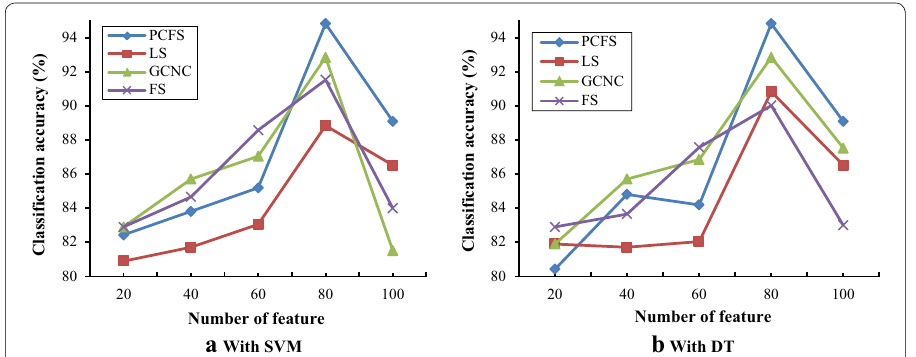
Fig. 4 Classification accuracy (average over 10 runs), on multiple features dataset with respect to the number of selected features with a SVM classifier, and b DT